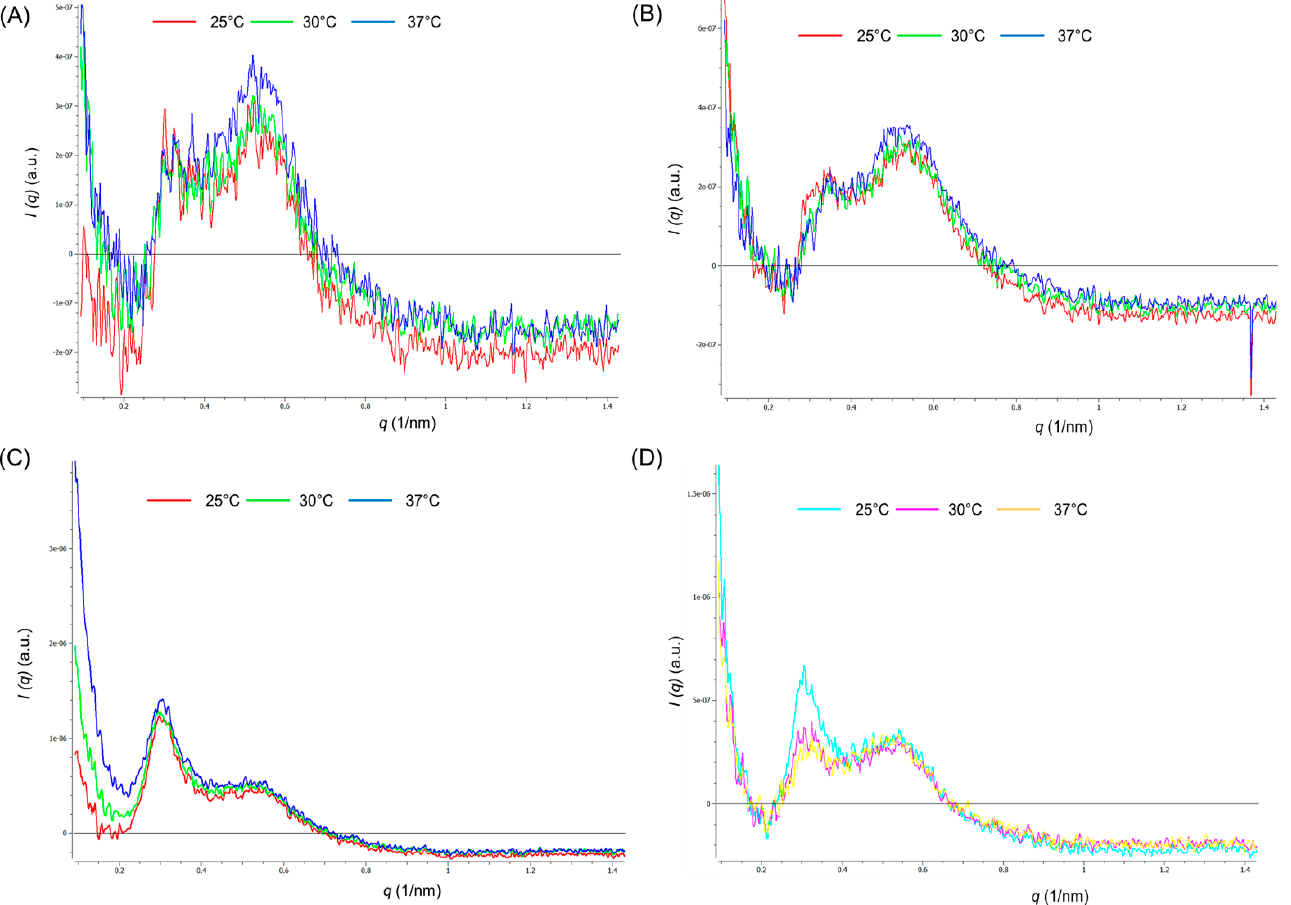
Figure 1. SAX structure of fluocinolone acetonide polymeric micelles (FPMs) 1 ( A ), 2 ( B ), 7 ( C ), 8 ( D ), 13 ( E ), and 14 ( F ) for all temperatures as 25 °C, 30 °C and 37 °C. 3.2. Effects of Independent Variables on Responses in Design Formulation The maximum concentrations of P407 and PEG provided the greatest viscosity for FPM1 and FPM2 (Table 2 and Figure 2A); in contrast, the presence of SPA did not signif- icantly affect their viscosity or the percentage of mucoadhesiveness. The impact of P407 on FPM viscosity might be explained by the nature of the self-molecule micelle, which acts as a reservoir in a polymeric matrix [28]. However, increasing the P407 ratio was not found to increase the percentage of mucoadhesiveness (Figure 2A), as FPM7 and FPM8